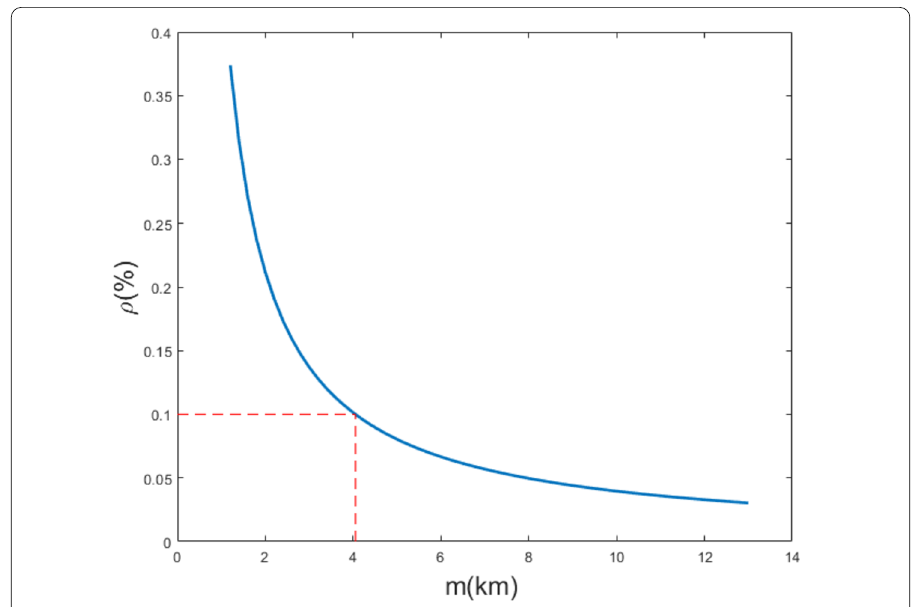
Figure 6 ρ and the path length m change between the diagram